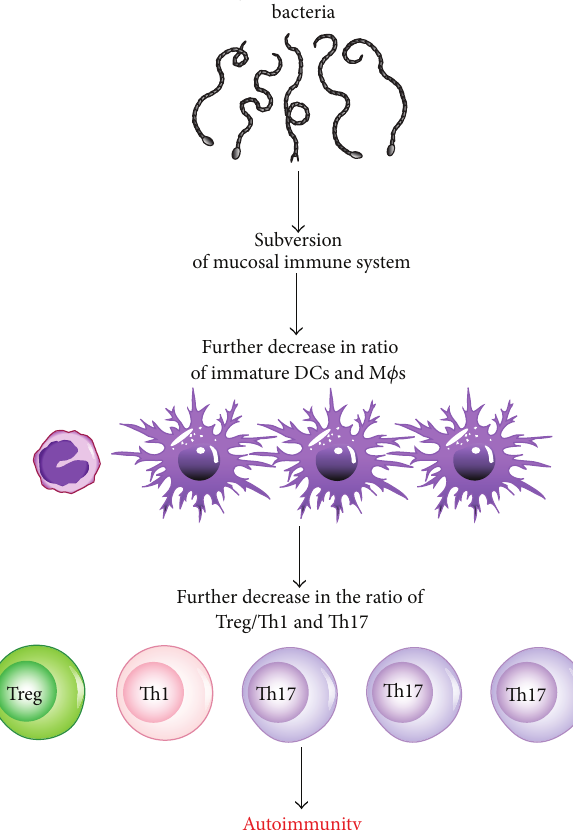
Figure 4: How segmented filamentous bacteria (SFB) can change the ratio between Th17 and Tregs, leading to